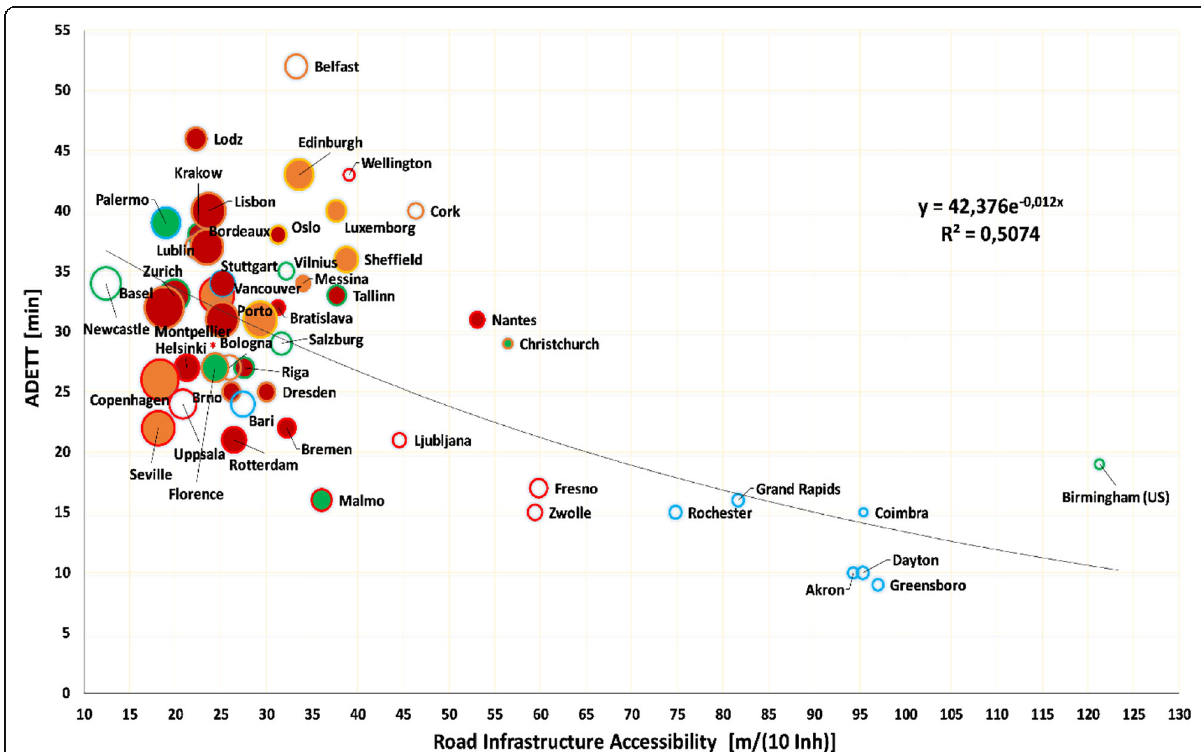
Fig. 4 Multi variant diagram of small cities. Congestion level (ADETT) over Road IA; Bubble size is proportional to the population density; filled color indicates Train IA, bubble border color indicates Cycle IA, color of starred city- labels indicate BRT IA. For color scaling, see Table.5. The dotted line represents the fitted exponential curve from Eq.(1)